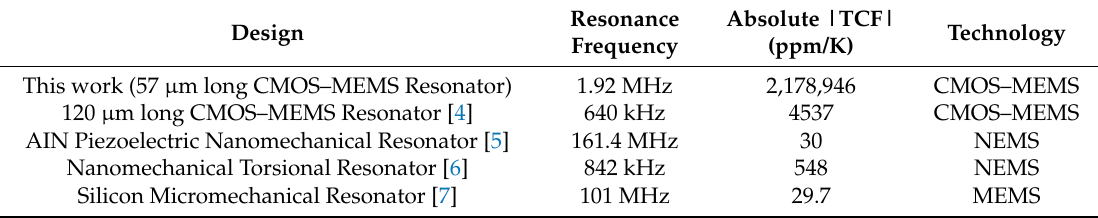
Table 1. Performance comparison between this work and literature. TCF–temperature coefficient of frequency, CMOS–complementary metal-oxide semiconductor, MEMS–Micro-Electro-Mechanical Systems, NEMS–Nano Electromechanical